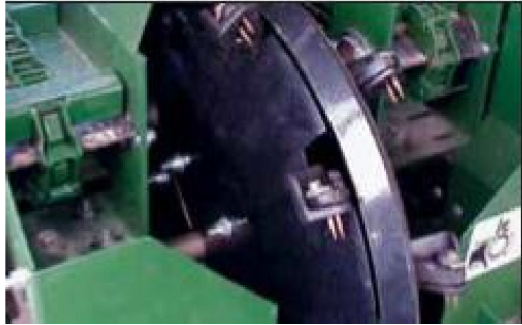
Figure 12. Needle-type seed metering device. Reprinted with permission from ref. [51] Copyright 2016 Lockwood Industries.